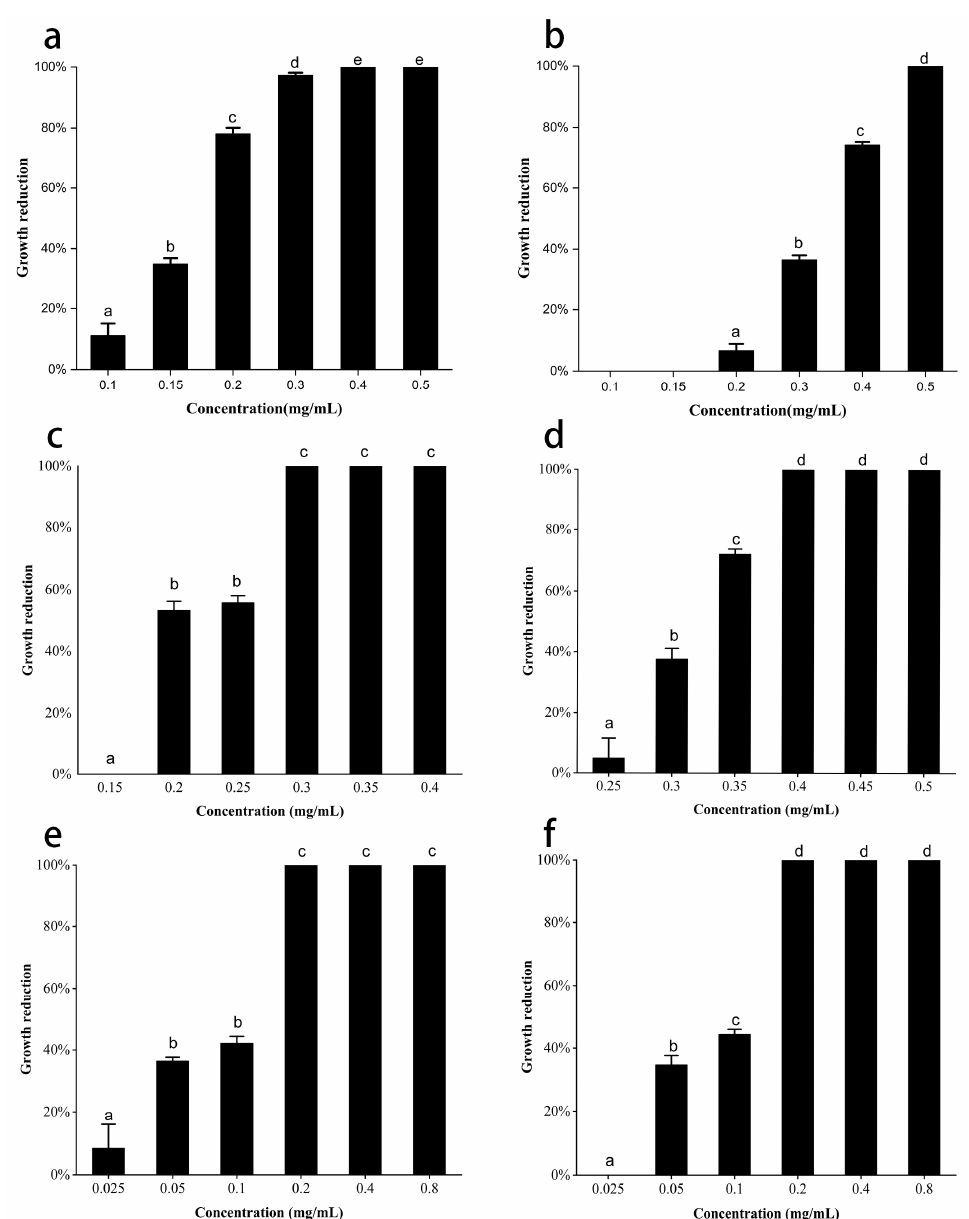
Figure 7. Growth reduction of E. coli and S. aureus treated with different concentrations of ( a , b ) free thymol; ( c , d ) Thy-MCM-41; and ( e , f ) Thy-SBA-15. The same letters in the bars show homogeneous group membership ( p < 0.05).